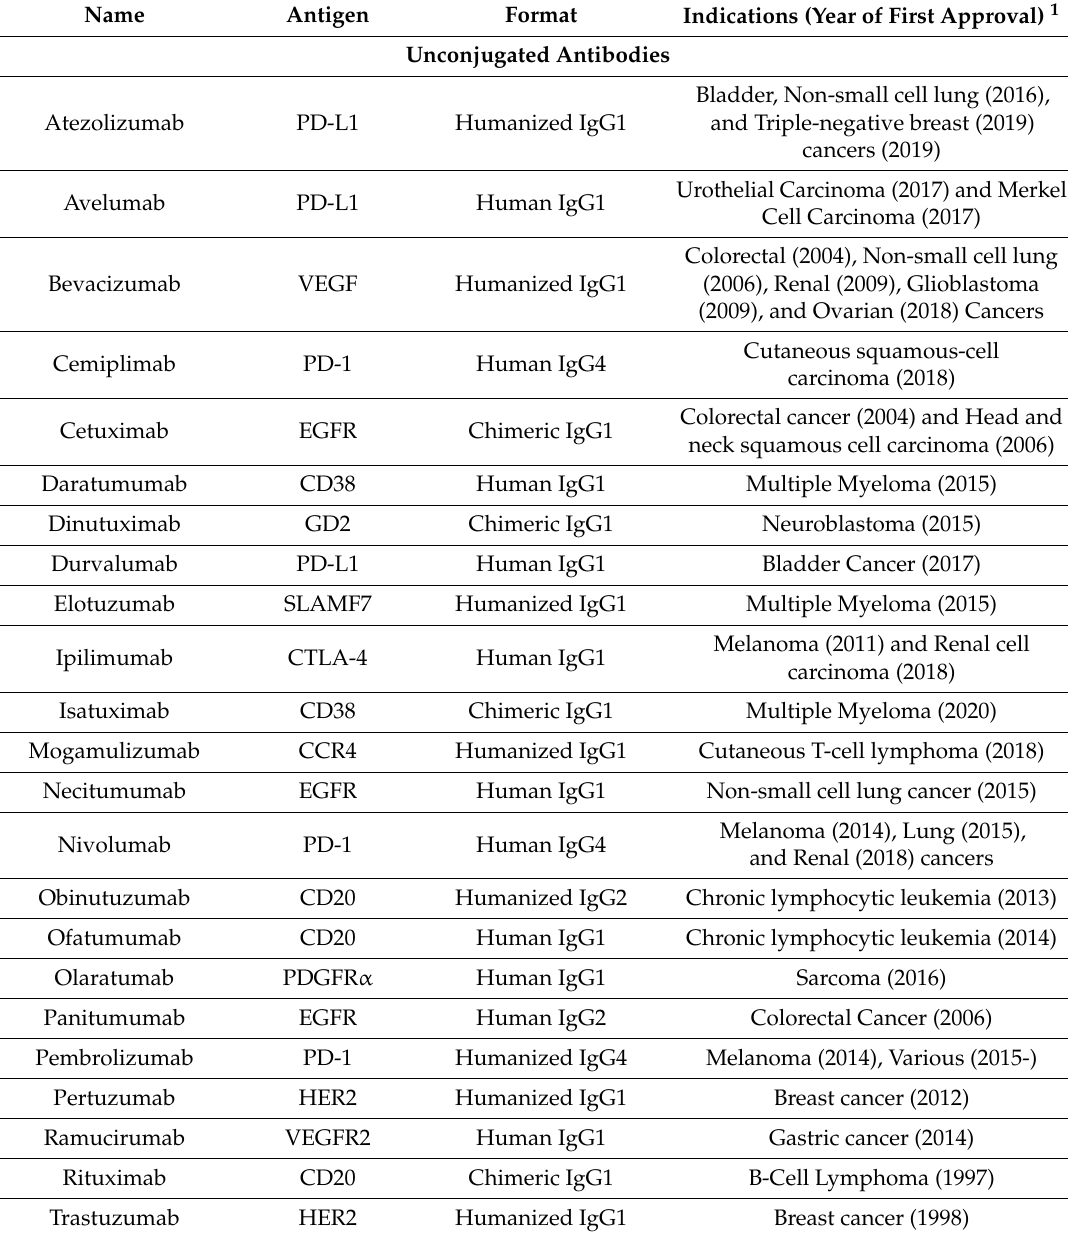
Table 1. FDA-approved monoclonal antibodies for